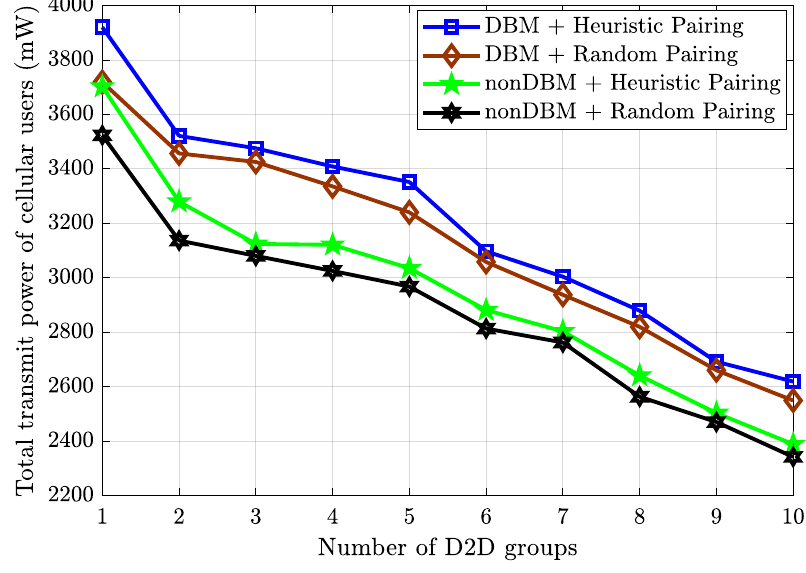
Figure 5. The total transmit power of cellular users versus the number of D2D